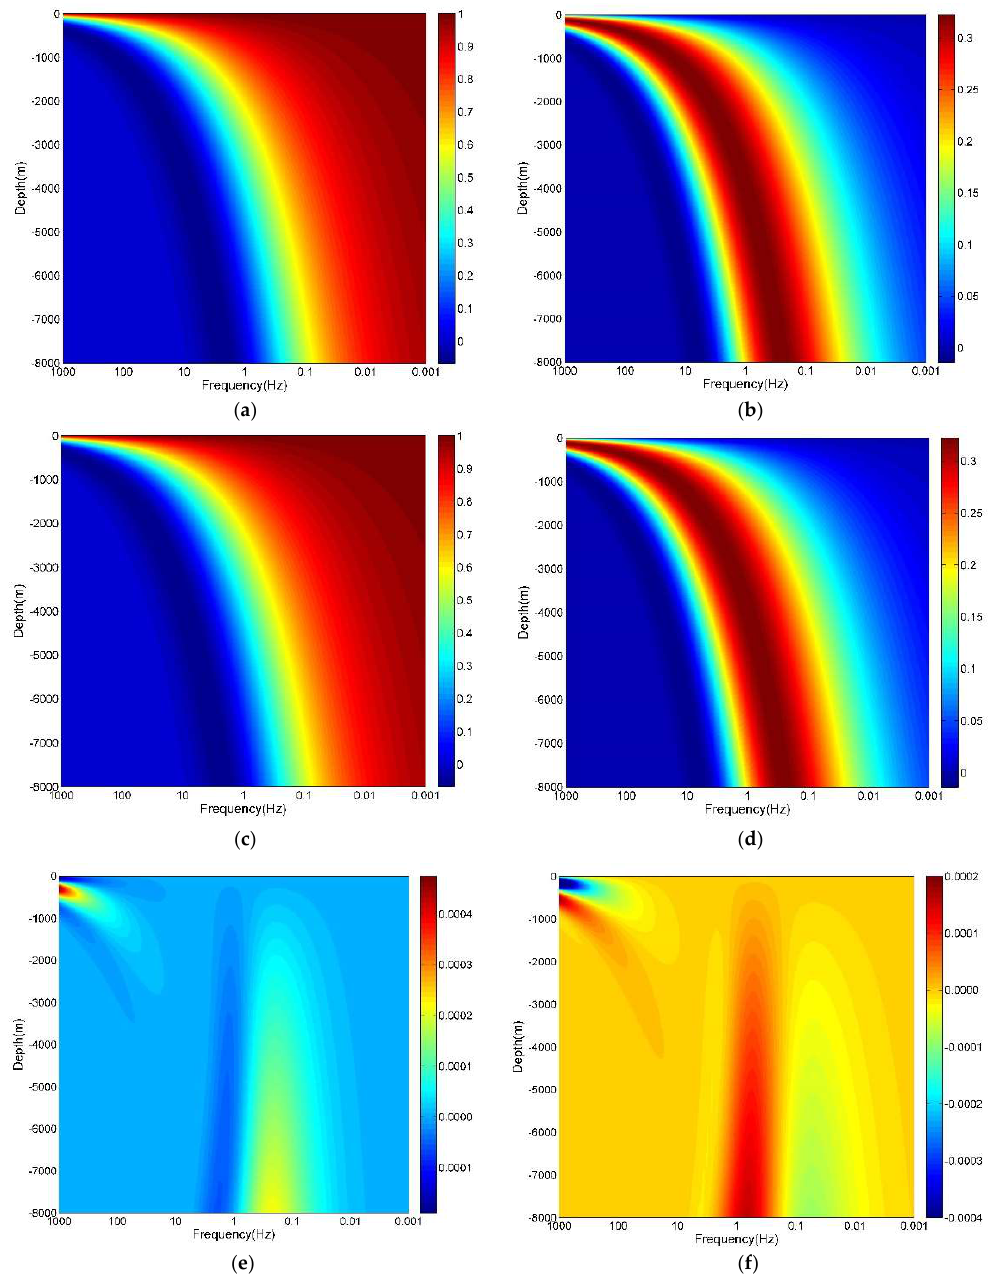
Figure 3. FD solution of magnetic field in homogeneous half-space model. ( a ) Numerical solution of real component; ( b ) Numerical solution of imaginary component; ( c ) Analytical solution of real component; ( d ) Analytical solution of imaginary component; ( e ) Relative error of real component; ( f ) Relative error of imaginary component.